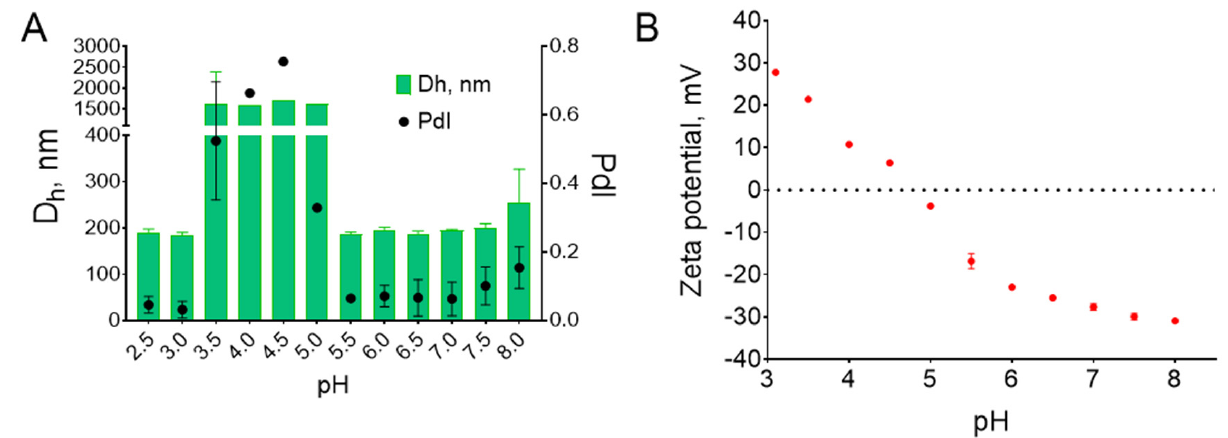
Figure 3. Colloidal stability of PB@BSA5/Str. ( A ) Mean hydrodynamic diameter (Dh) and polydis- persity index (PdI) of nanoparticles (10 µ g/mL) in McIlvaine buffers with various pH values. ( B ) Zeta potential of nanoparticles (50 µ g/mL) in 5 mM citrate-phosphate buffer. Means ± SDs of 3 technical replicates are presented.